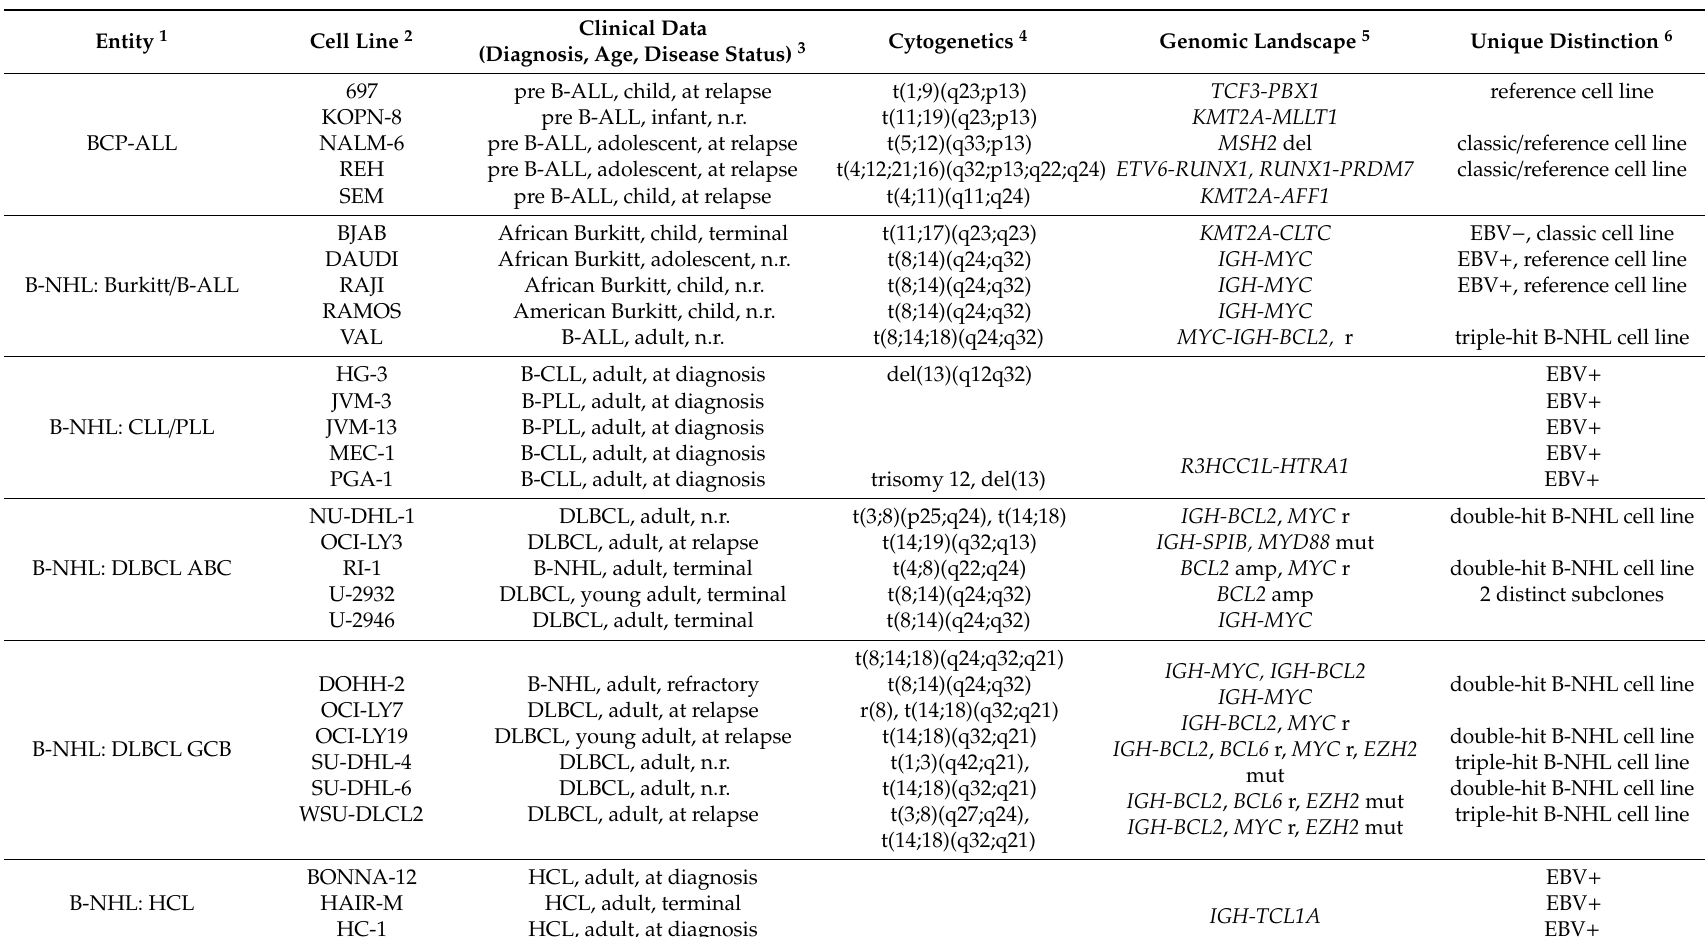
Table 2. The LL-100 Panel: Selected Key Genetic Features and Unique